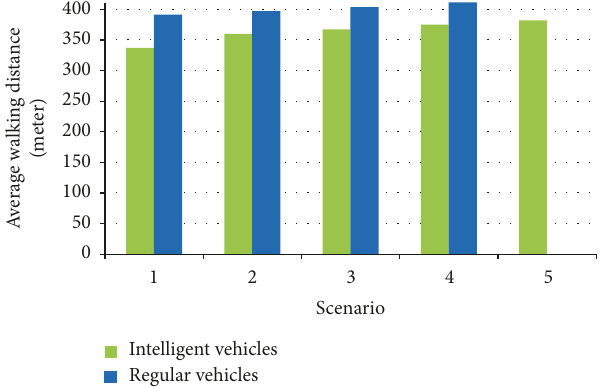
Figure 8: Average walking distance with the scenarios.